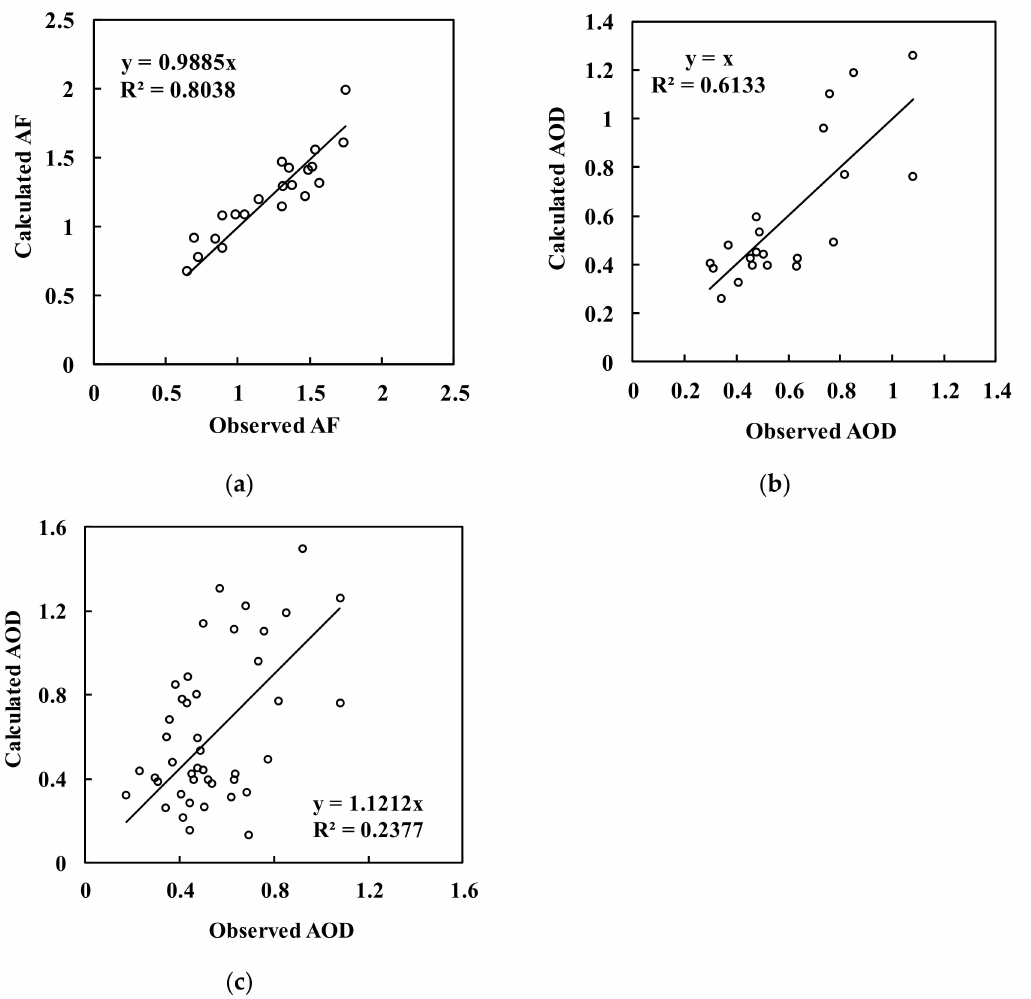
Figure 8. Scatter plot of calculated vs. observed AF ( a ) or aerosol optical depth (AOD) ( b ) for situation B and AOD ( c ) for situation